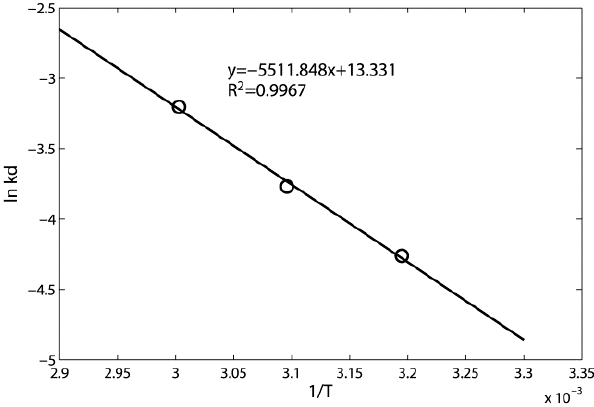
Figure 7. The Arrhenius plot for reaction constants of silica gel thermal desorption.